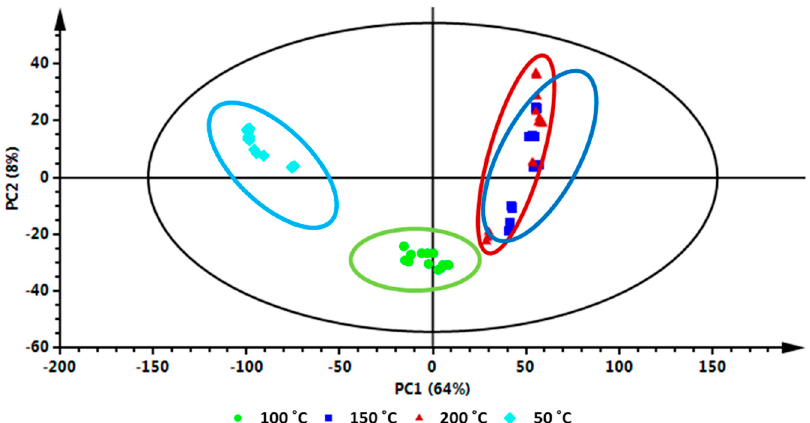
Figure 2. Principal component analysis (PCA) of the ultra-high performance liquid chromatography- mass spectrometry (UHPLC-MS) chromatograms from negative ionization data. The 2D score plot, explaining 72% of the total variation, shows differences in the clustering patterns of V. fastigiata samples extracted at different temperatures using PHWE.